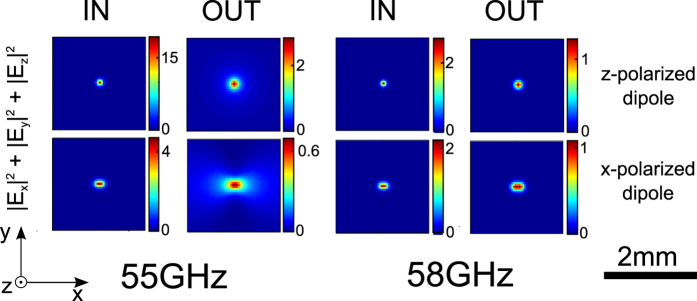
Intensity point spread function for x- and z-polarized dipoles from Figs. 3 and 4.